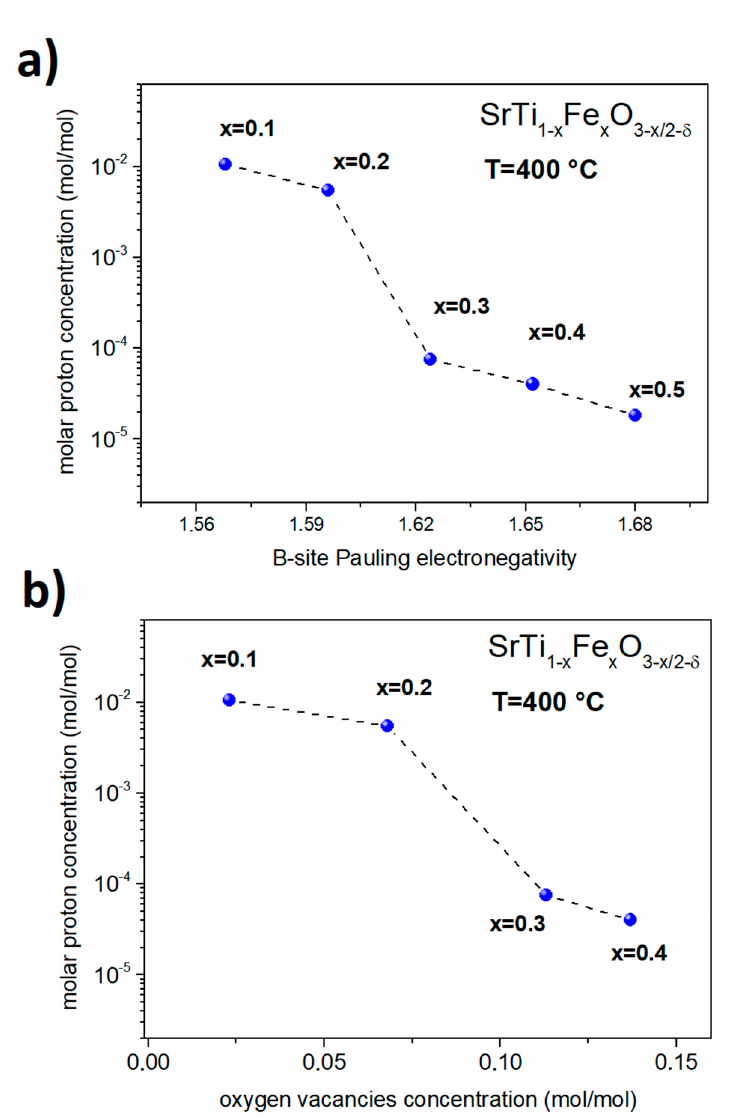
Figure 7. ( a ) Proton concentration at 400 ◦ C plotted versus B-site Pauling electronegativity; ( b ) total oxygen vacancy concentration measured at 400 ◦ C in